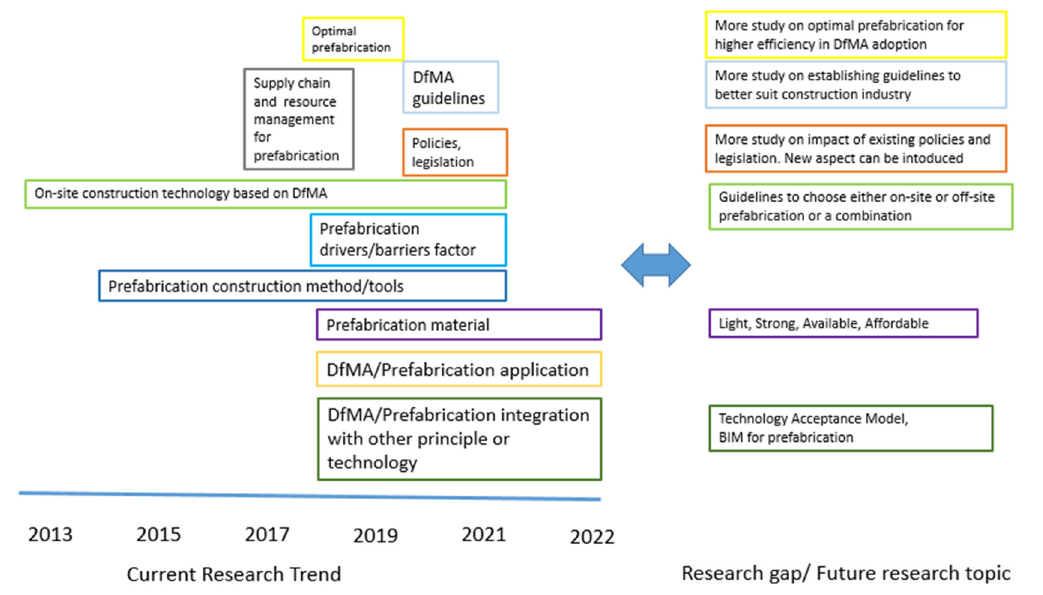
Figure 7. DfMA research framework based on trends of research theme.